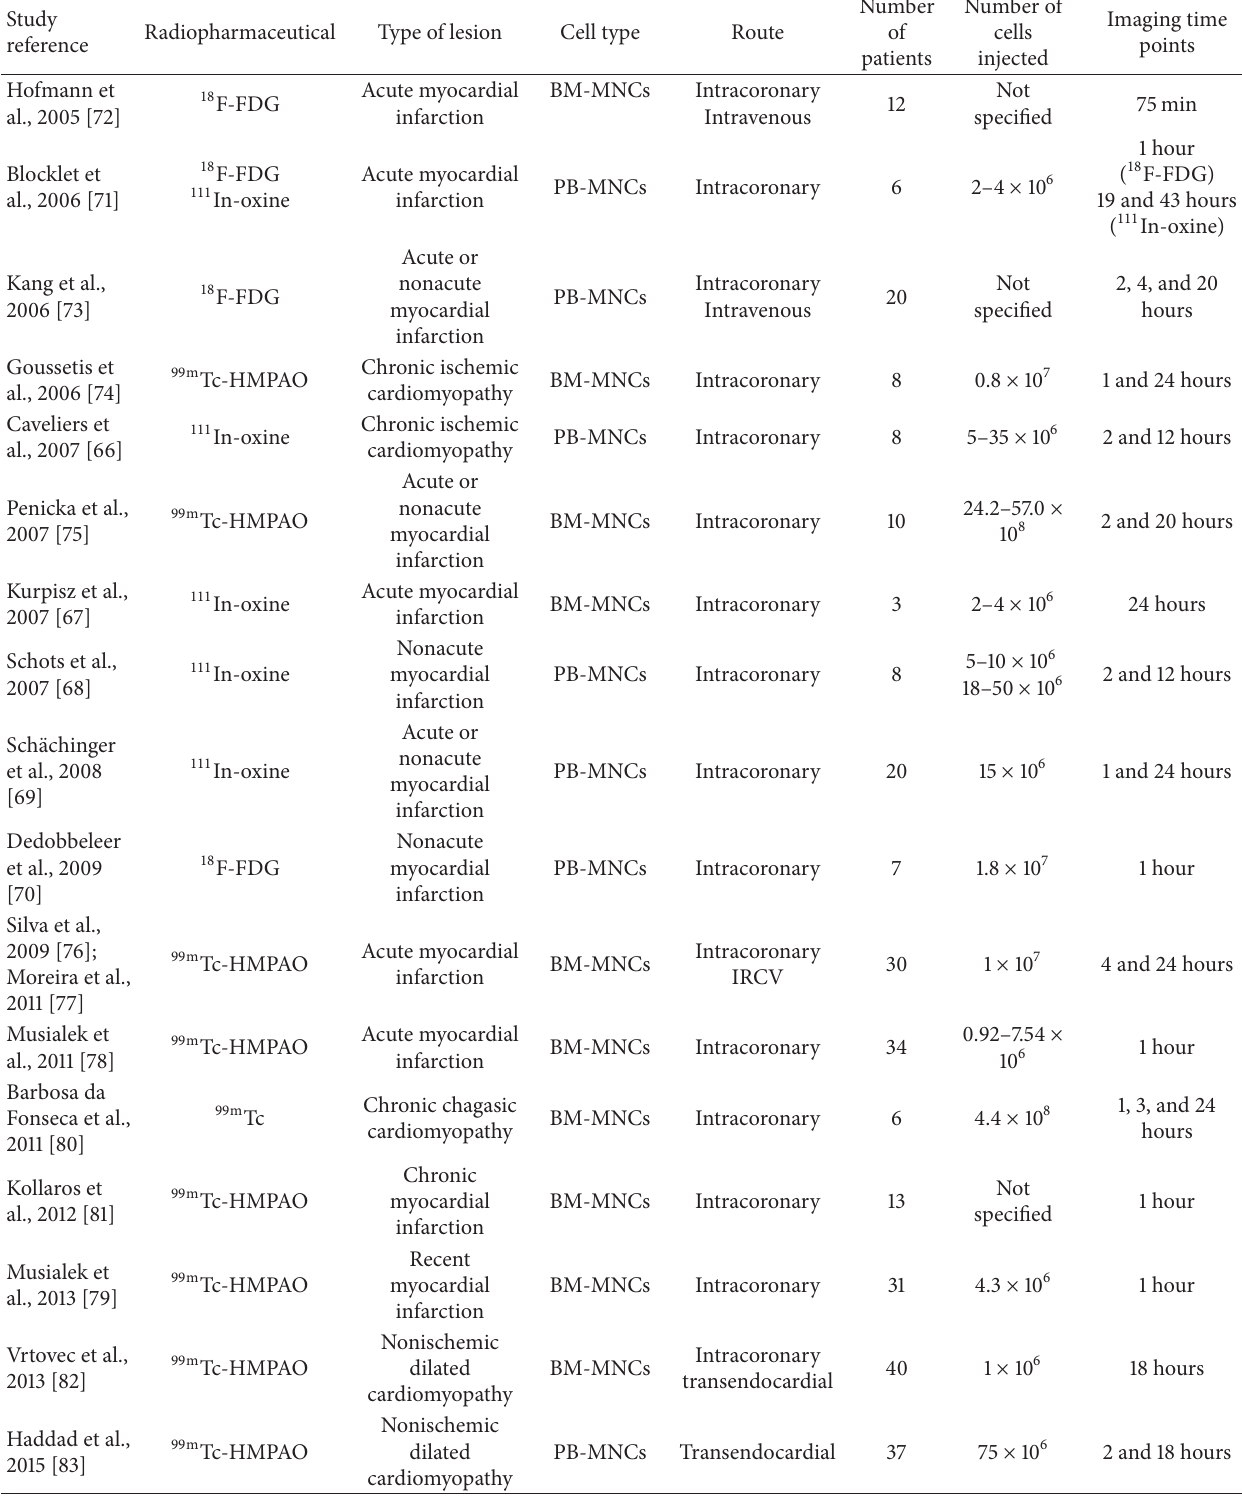
Table 3: Clinical studies that used direct radiopharmaceutical labeling for cell therapies in